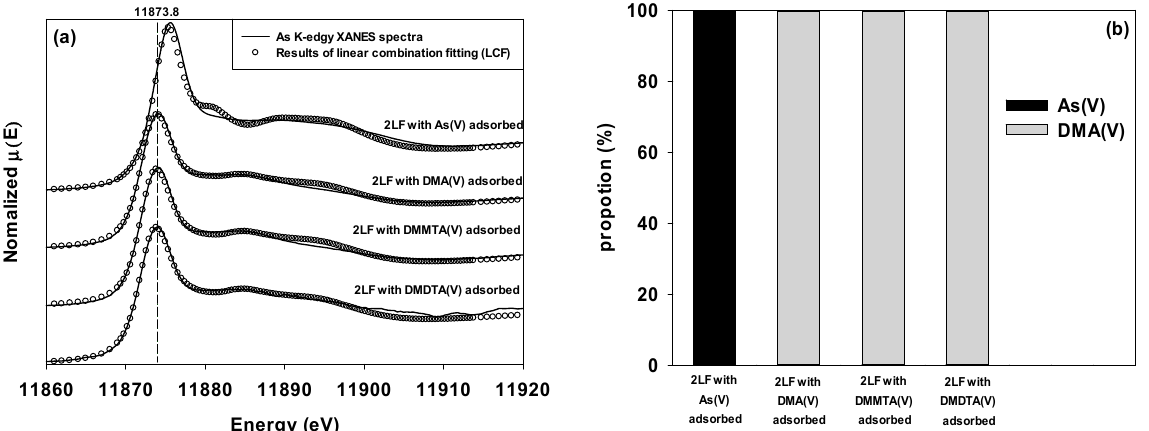
Figure 4. ( a ) LCF results of each As species adsorbed on two-line ferrihydrite (2LF) (open circles),